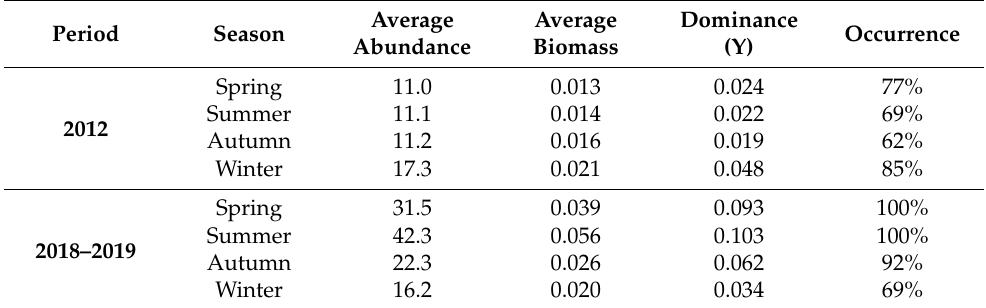
Table 1. Comparison of the ecological characteristics of Brachionus calyciflorus in 2012 and in